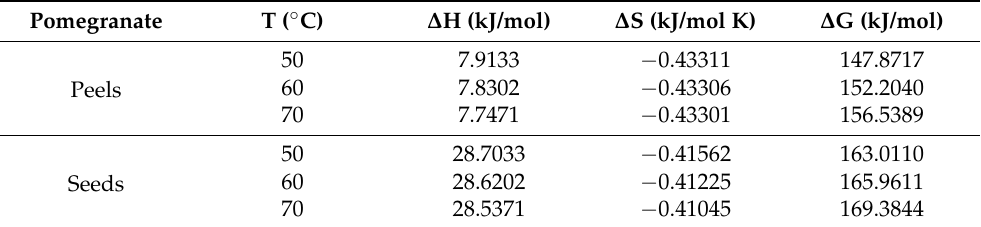
Table 7. Thermodynamic properties of drying kinetics of dried pomegranate peels and seeds at temperatures of 50, 60, and 70 ◦